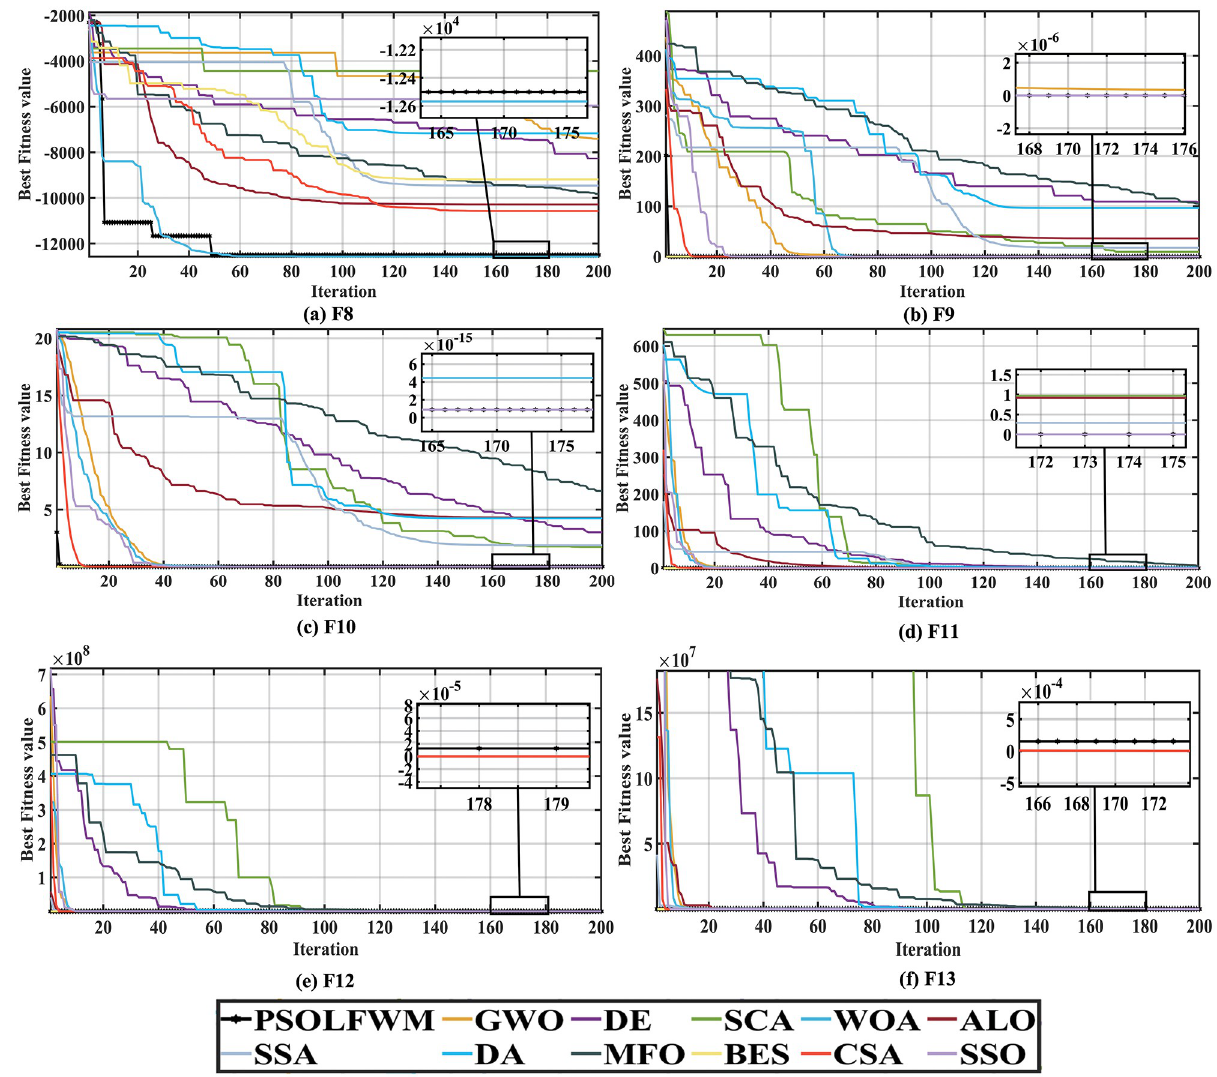
Fig 6. Convergence curve of others functions compared with the meta-heuristic algorithms. (a) F8, (b) F9, (c) F10, (d) F11, (e) F12, and (f) F13.